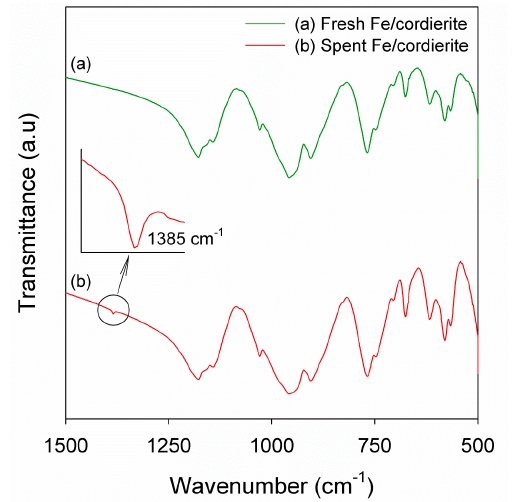
Figure 3. FTIR spectra of Fe/cordierite before and after ozone decomposition with air